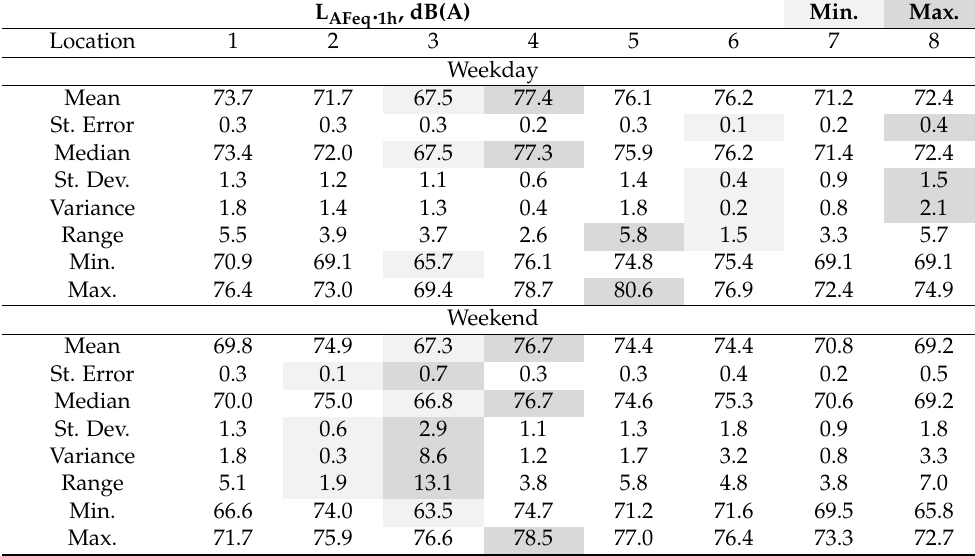
Table 5. Descriptive statistics of noise level measurements (n = 16